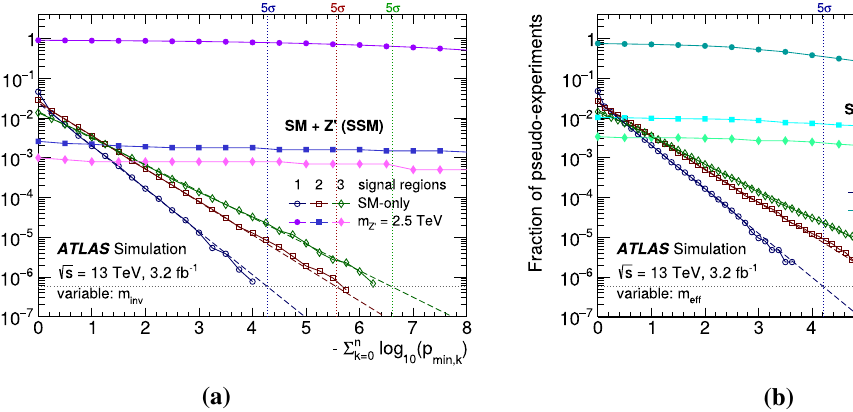
Fig. 9 The fraction of cases in which the first pseudo-experiment has P exp , i < 5% and triggers a second pseudo-experiment which (cid:12) n ( p ) smaller than a given value yields a value for − (cid:12) 0 k k = 1 log 10 n ( p ) ). Here n denotes the minimum number of event ( − min , k k = 1 log 10 classes (1, 2 or 3) for which P exp , i < 0 . 05. The distribution is shown for pseudo-experiments generated from the SM expectation, and from an SM-plus-signal expectation of a inclusive decays of a Z (cid:8) boson with